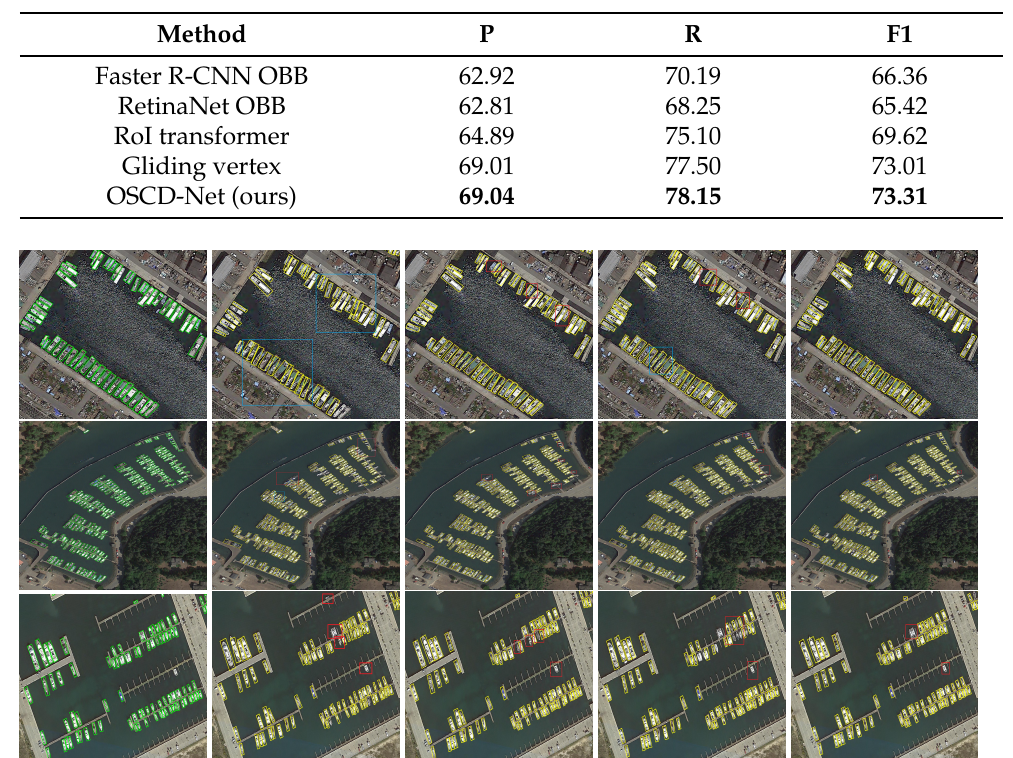
Table 6. Performance evaluation with Precision(P), Recall(R) and F1 on the DOTA-Ship dataset. The highest value is indicated by bold numbers (%).